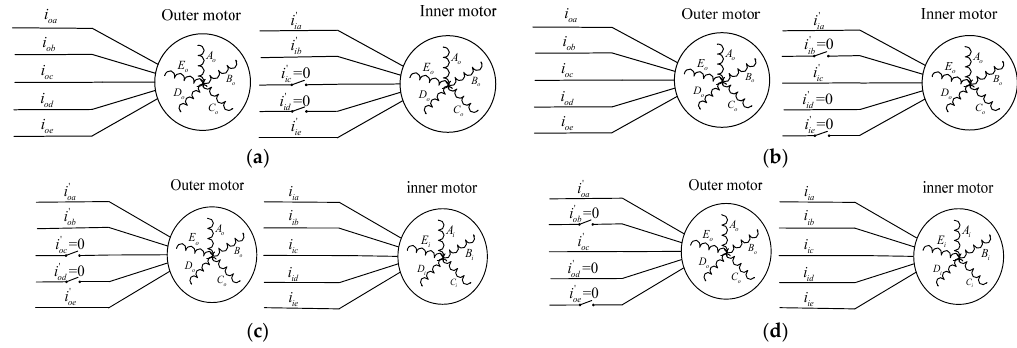
operates normally (Figure 19d).